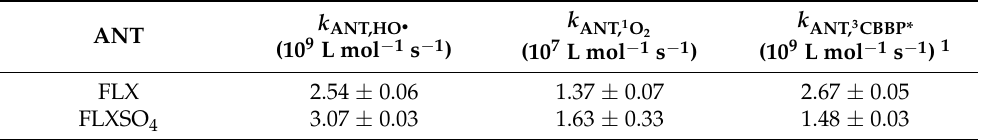
Table 2. Second-order kinetic rate constants of the reactions between antidepressants (ANT) and reactive photoinduced species ( 1 O 2 , HO • , 3 CBBP*) in pure water at natural pH. ANT